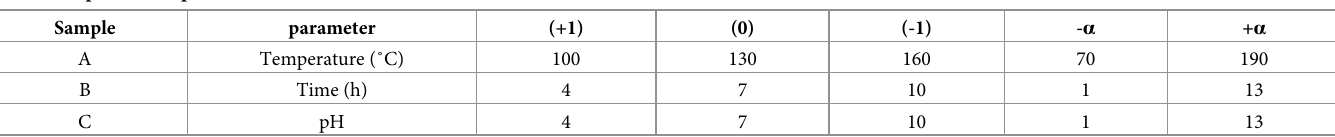
Table 1. Experimental parameters and their